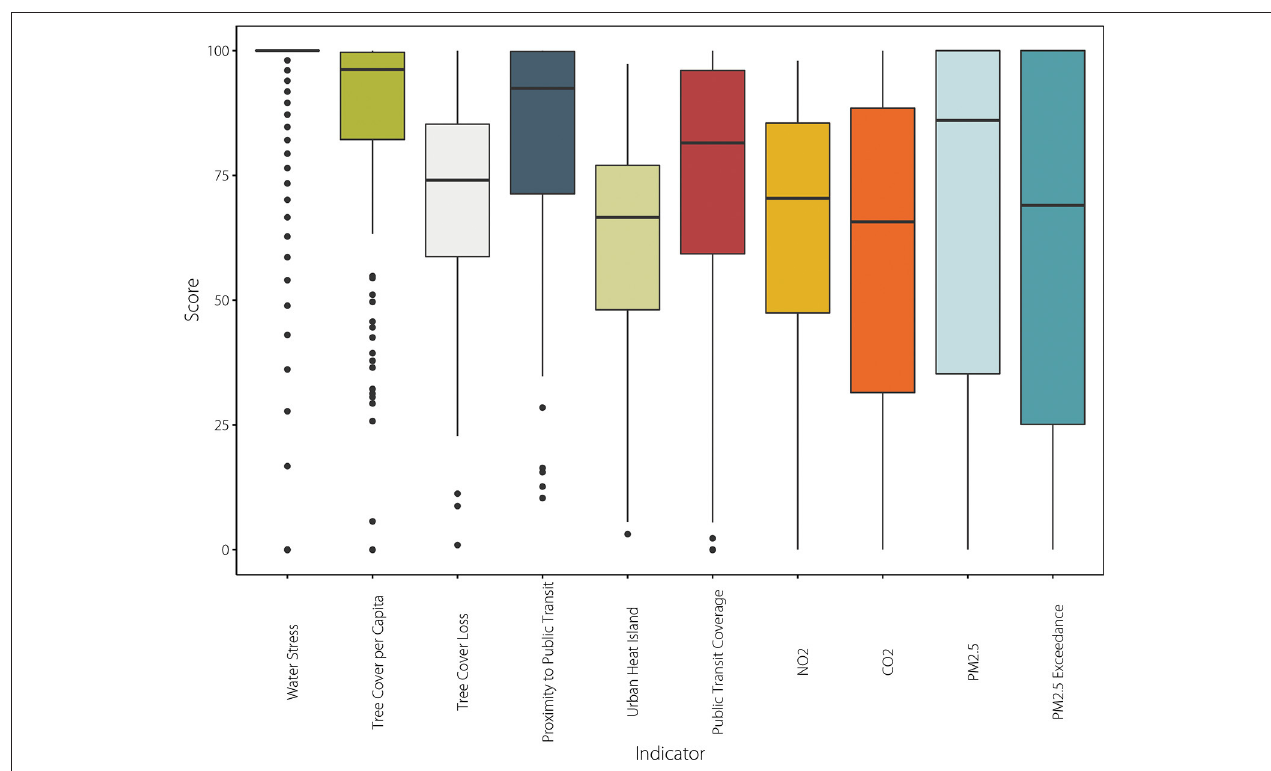
FIGURE 4 | Summary proximity-to-target scores for environmental metrics captured by the